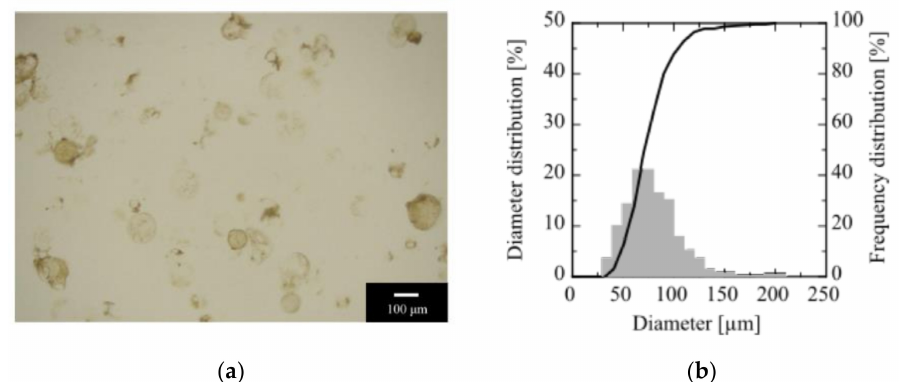
Figure 2. Optical microscopy image ( a ) and particle size distribution ( b ) of the magnetite-containing